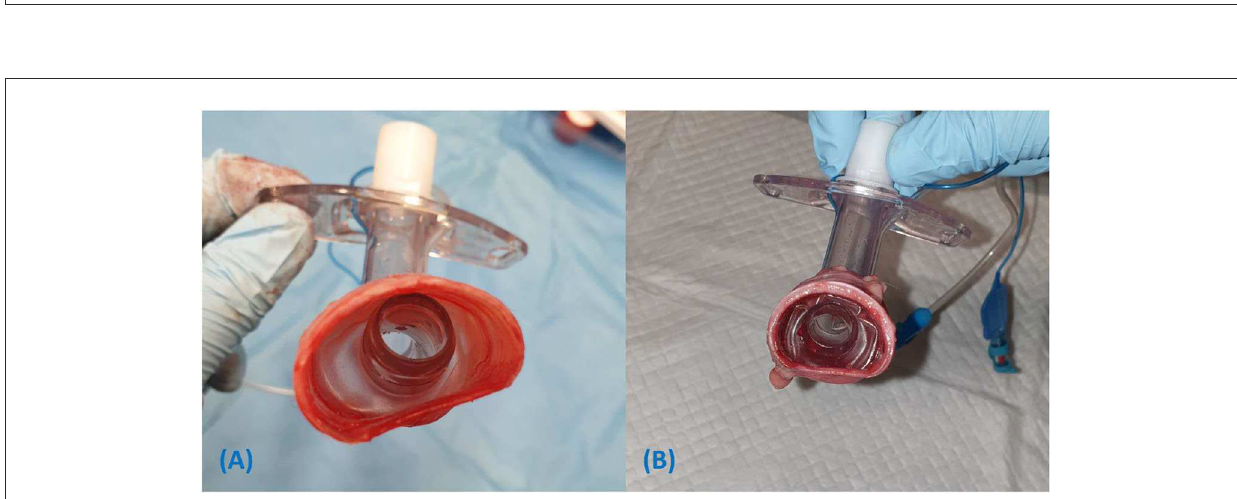
FIGURE8 (A) The tube cuff of the 10.0mm tracheostomy tube inflated to 20cm H 2 O conforms to the ovoid shape of the trachea in cadaver dog 3. (B) Folding of the 10.0mm tube cuff within the relatively small trachea of cadaver dog 9, allowing channels for air leak. Cadaver 9 had air leak with the larger 10.0mm tube but not the smaller 8.0mm